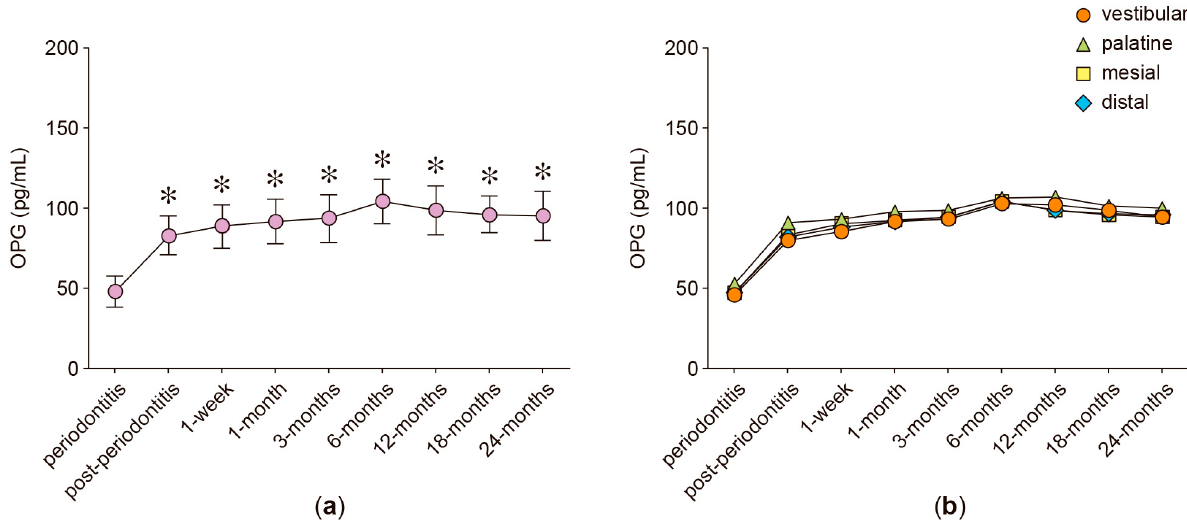
Figure 2. OPG levels. ( a ) OPG levels detected in the gingival crevicular fluid of periodontally com- promised anterior teeth before periodontitis treatment (periodontitis), after periodontitis treatment